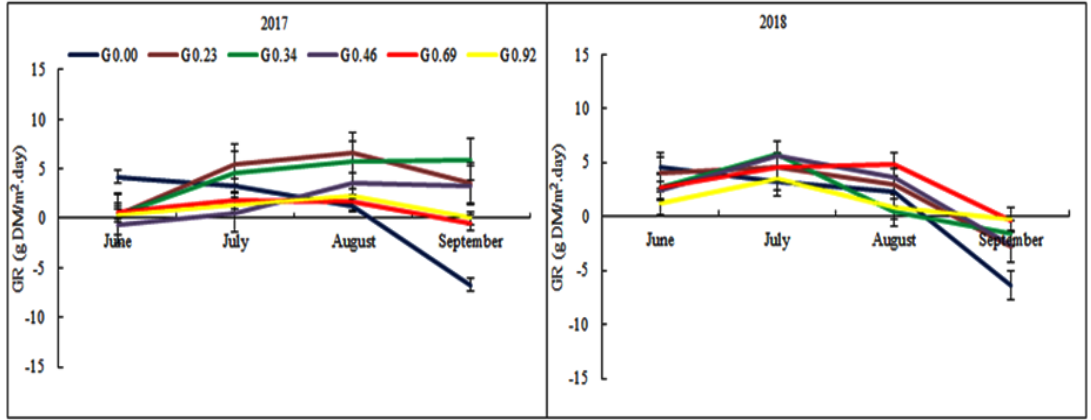
Figure 6. E ff ect of grazing intensity and season on growth rate Figure 6. Effect of grazing intensity and season on growth rate (GR).